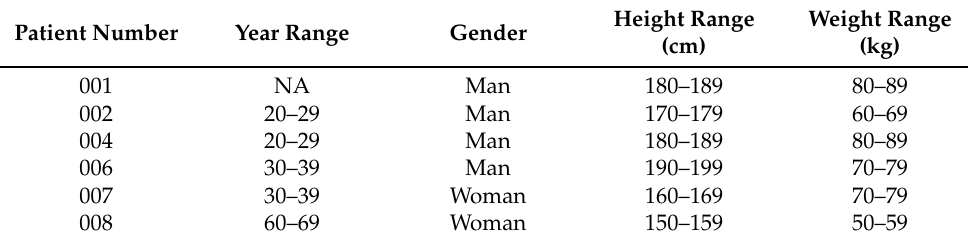
Table 2. Extended information about relevant T1DM patients in the D1NAMO